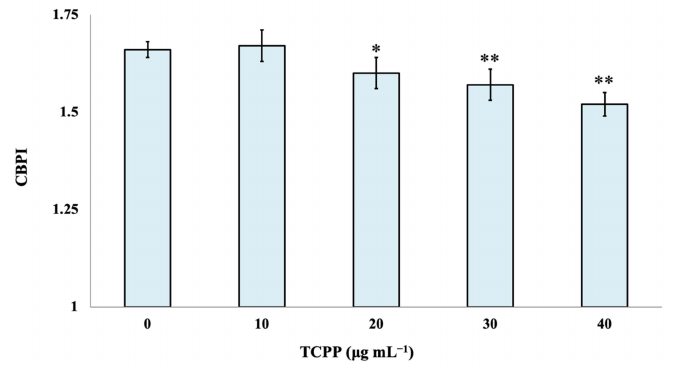
Figure 2. Cytotoxic effects of TCPP in human lymphocytes. CBPI values are expressed as mean frequencies (‰) ± standard error. * p < 0.05, ** p < 0.001 (significant differences compared to the control value, χ